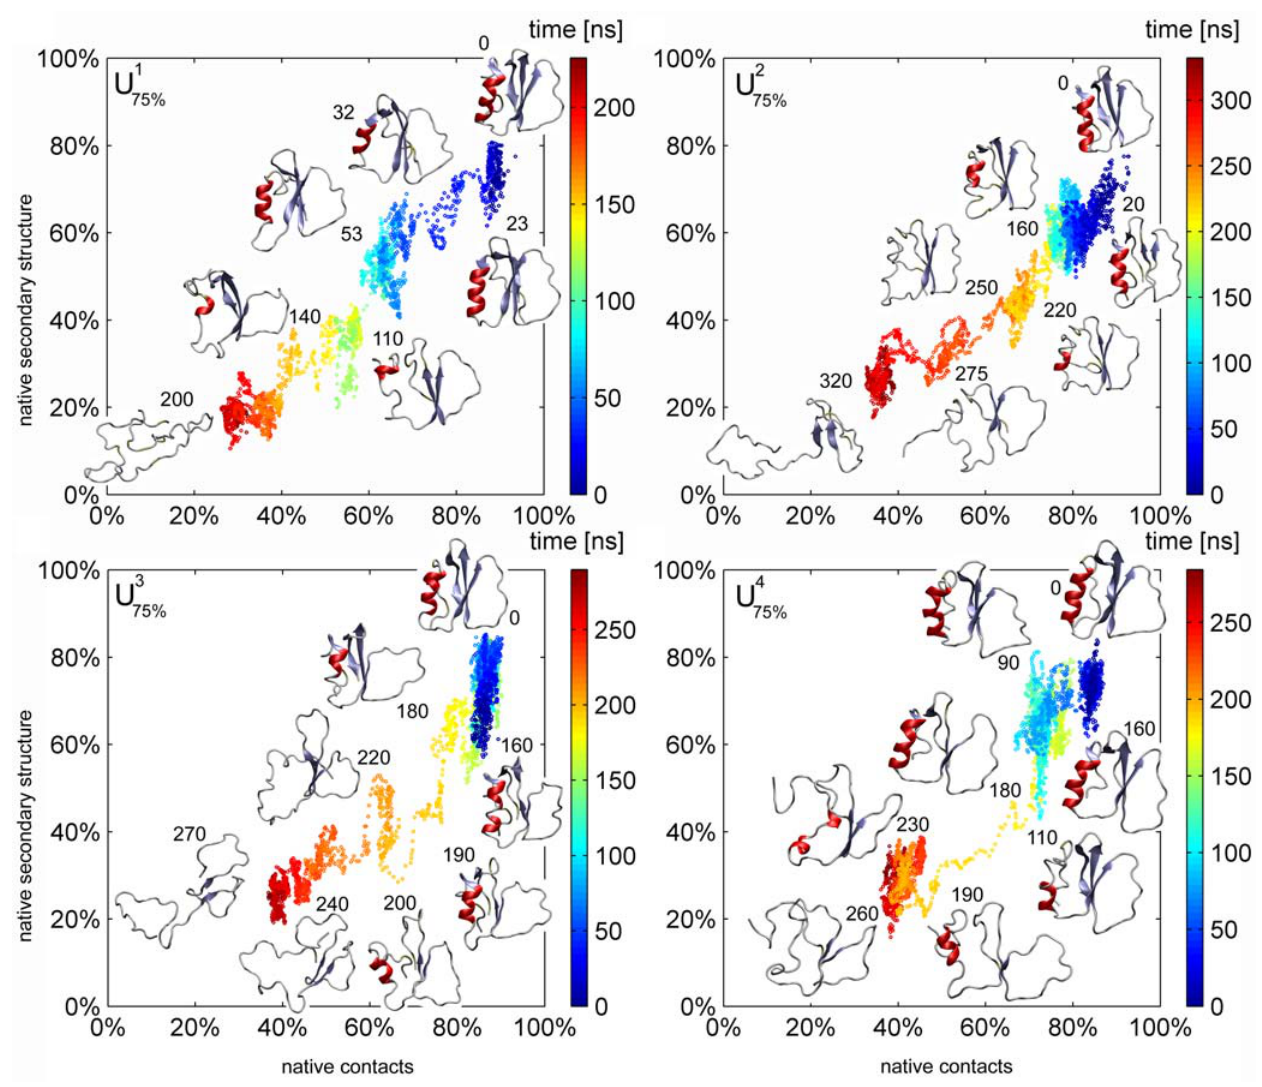
Figure 4. Unfolding pathways of the CI2 for the simulations in urea 75% , displayed as native secondary structure content versus native contact content. The numbers next to the protein structures denote the respective time of the snapshot in ns.